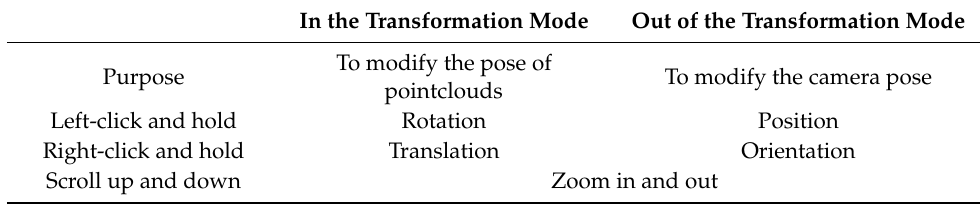
Table 10. Comparison of mouse actions in versus out of the transformation mode.